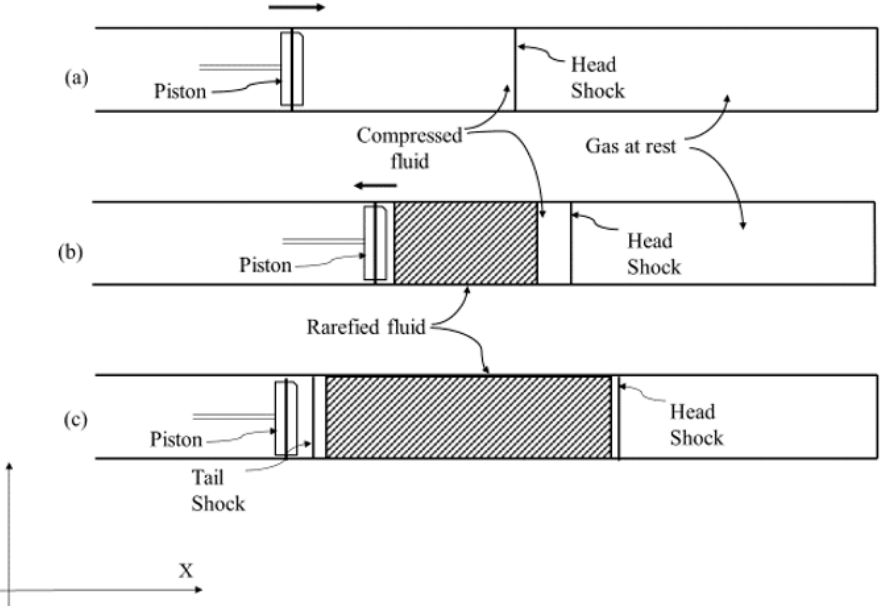
Figure 3. Generation of shock and rarefaction waves [Adopted based on a figure in Courant, (1948)].